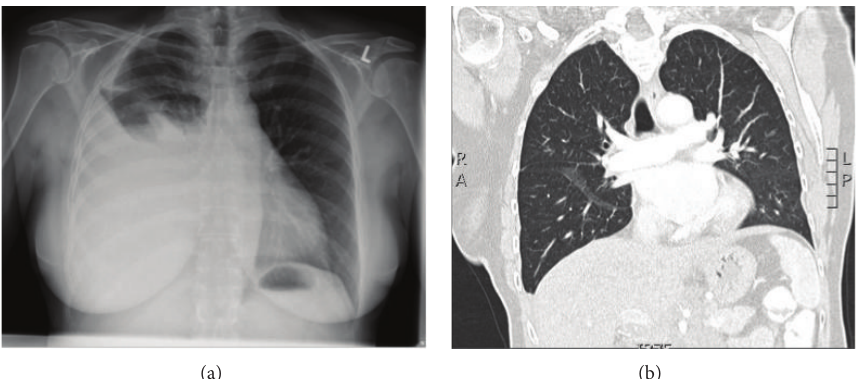
Figure 1: Chest X-ray before radiotherapy: large amount of pleural fluid (right) (a) with complete remission 3 months after radiotherapy on CT thorax (b).